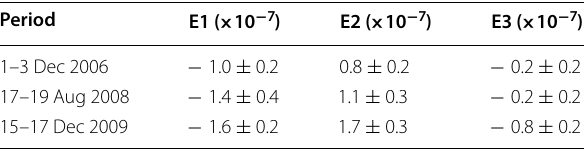
Table 1 Changes in strain in each direction during each